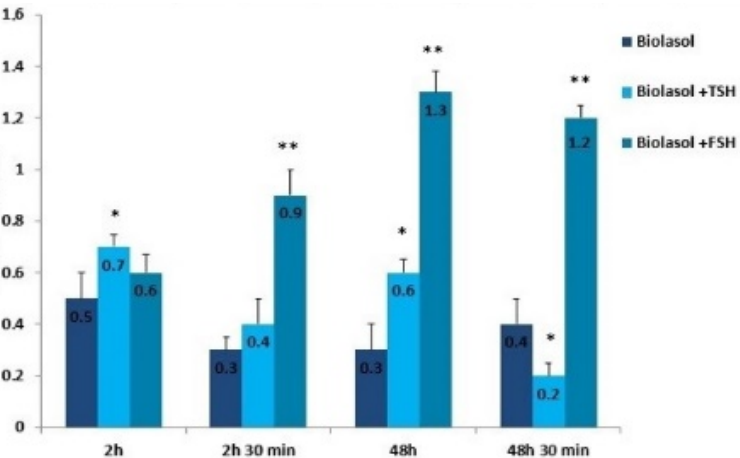
Figure 4. Creatinine concentrations in the collected perfusates. The values are expressed as mean ± SEM. * p < 0.05; ** p < 0.01 compared to the control group (Biolasol).